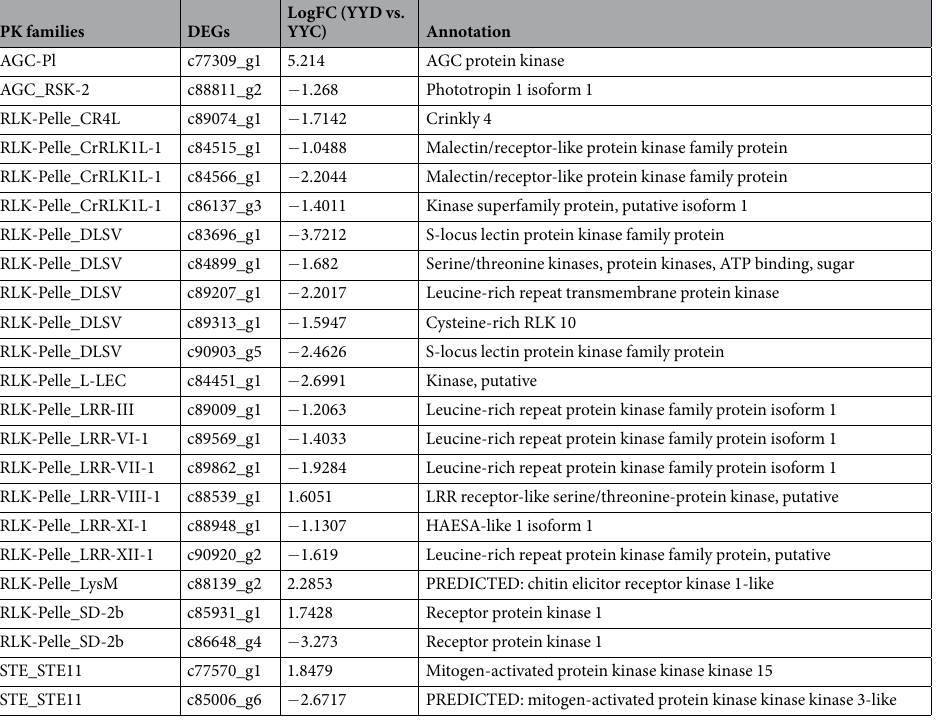
Table 5. Analysis of protein kinase differentially expressed genes (DEGs) in drought-sensitive Corchorus capsularis (YY) under drought stress (YYD) and normal (YYC) conditions. FC: fold